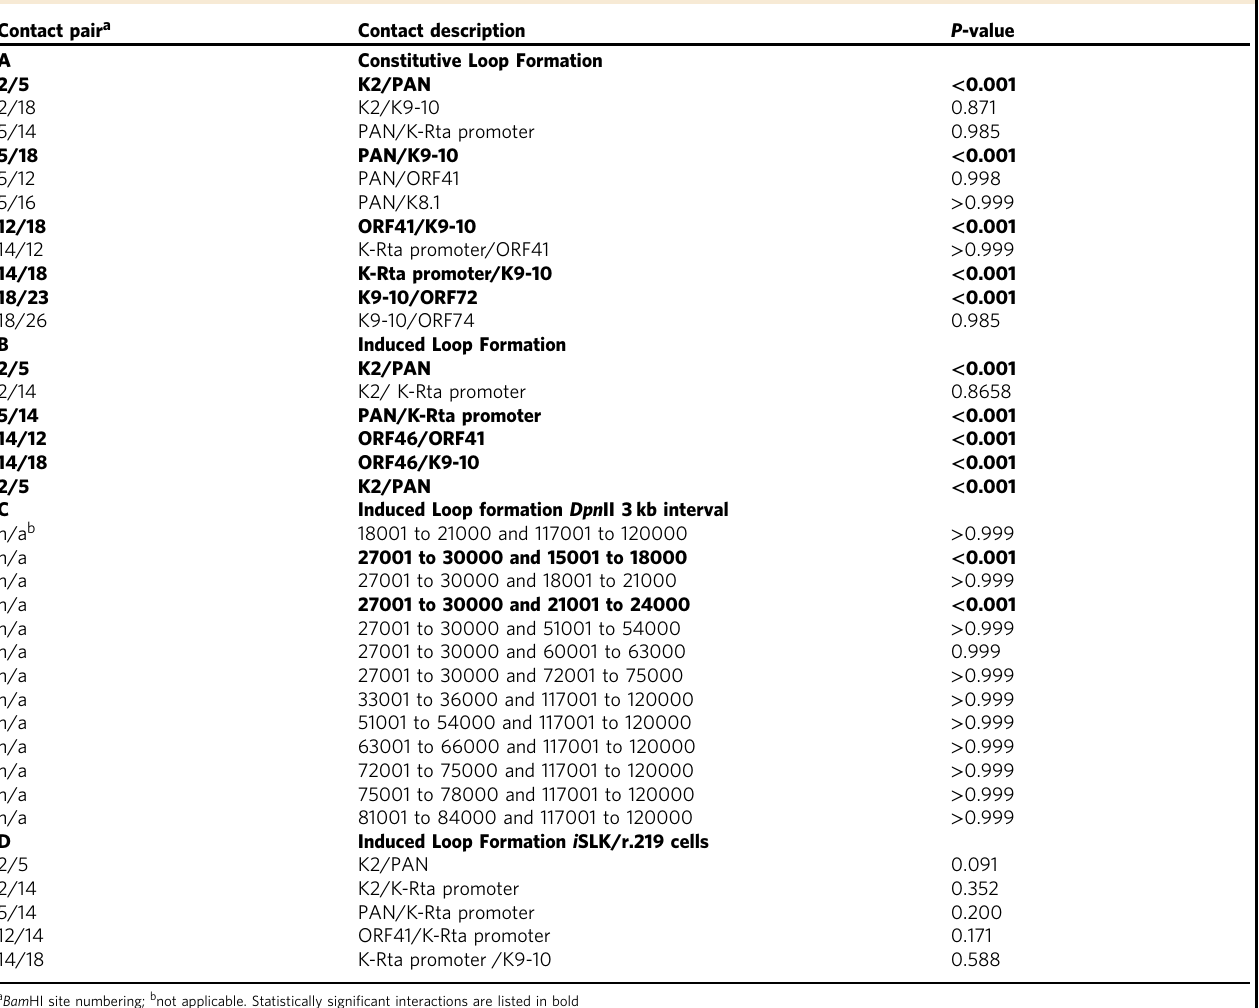
(Table 1). Representative fi gures from one of the triplicates are shown in Fig. 6. Similar to TREx-K-Rta BCBL-1 cells, genomic loops within lytic genes were increased compared to those of latent gene cluster regions (Fig. 6b, and Supplementary Fig. 4a).